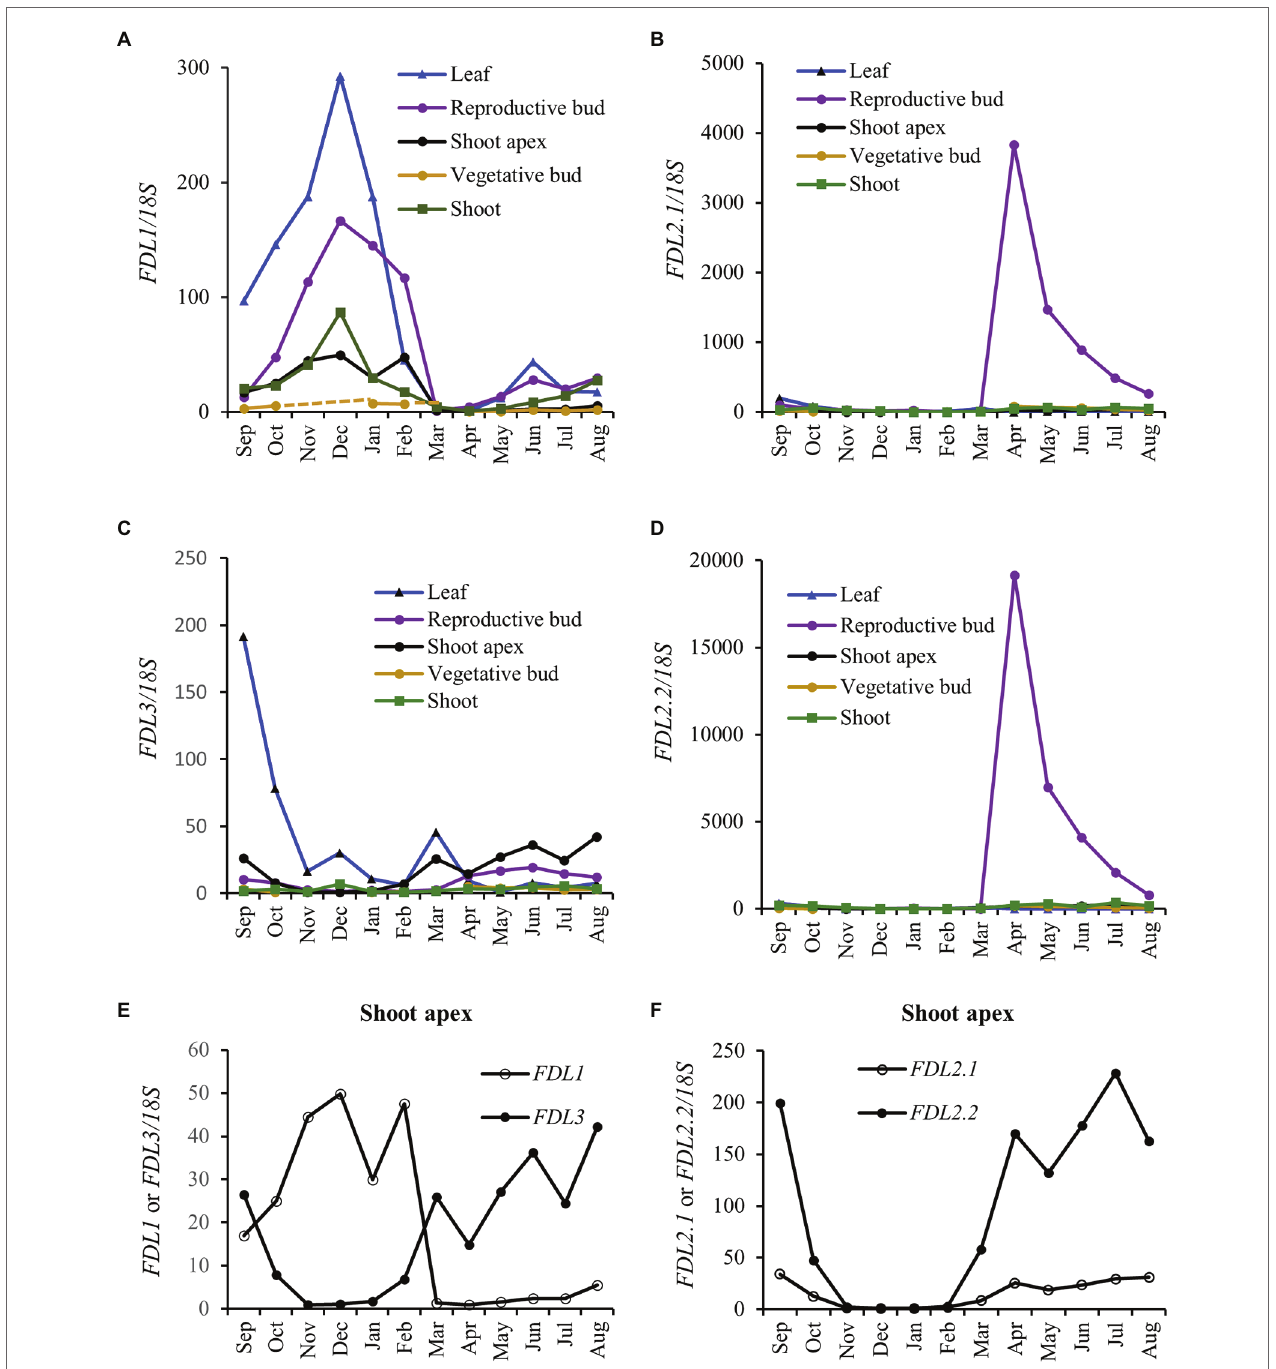
FIGURE 1 | FLOWERING LOCUS D-LIKE ( FDL ) genes differ in regulation. Relative expression is fold change in transcript levels of (A) FDL1 , (B) FDL2.1 , (C) FDL3 , and (D) FDL2.2 relative to the time point with the lowest expression within a tissue ( n = 3, except for shoot apex where the three apices were pooled to provide sufficient sample for analysis). FDL expression was normalized against reference gene 18S rRNA . (E) FDL1 and FDL3 and (F) FDL2.1 and FDL2.2 expression in shoot apices is presented separately to allow comparison of circannual patterns among the different FDLs . Axillary reproductive bud flush began in late February with anthesis reached in March (April sample is newly initiated floral bud). From September to March, preformed leaves and shoots were dissected from terminal